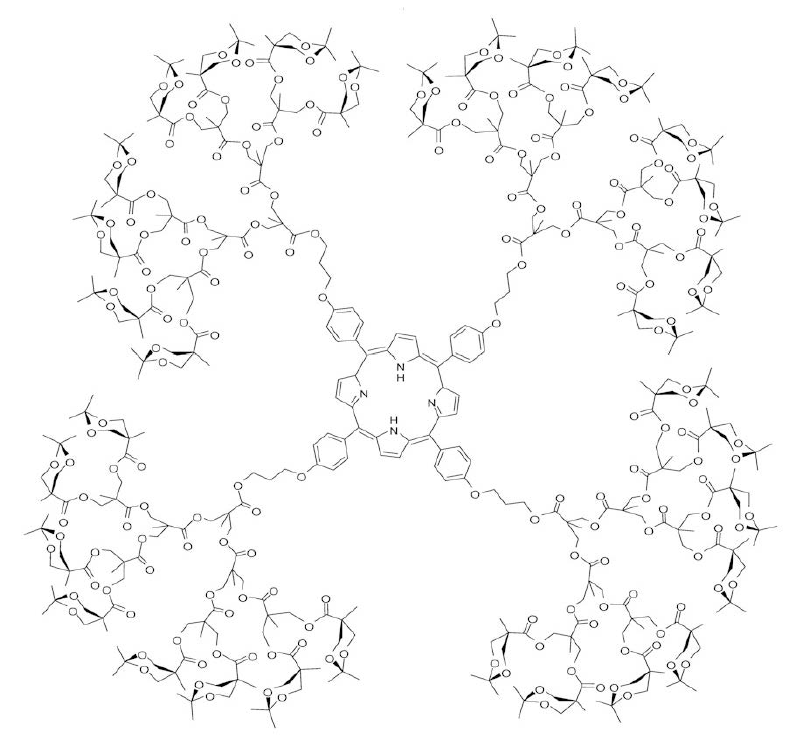
Figure 1. Porphyrin-cored 2,2-bis (methylol) propionic acid dendrimers for n =